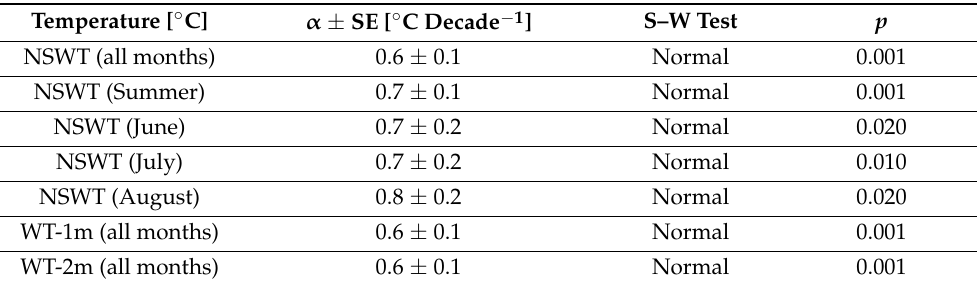
Table A1. The slope ( α ) with its standard error (SE) of the obtained linear fit of deseasonalized monthly anomalies of near-surface water temperature (NSWT), water temperature at a depth of 1 m (WT-1m), and of 2 m (WT-2m), based on in-situ observations between 9 LT–10 LT, during the study period (2003–2019). The decision based on the Shapiro-Wilk normality test for residuals (S-W test) and the significance level ( p ) is also displayed. If the p value was too high as compared with the 0.05 significance level, the obtained linear fit was considered as statistically insignificant. In addition, slopes were obtained for year-to-year variations of MSWT in the summer season and in each summer month separately.